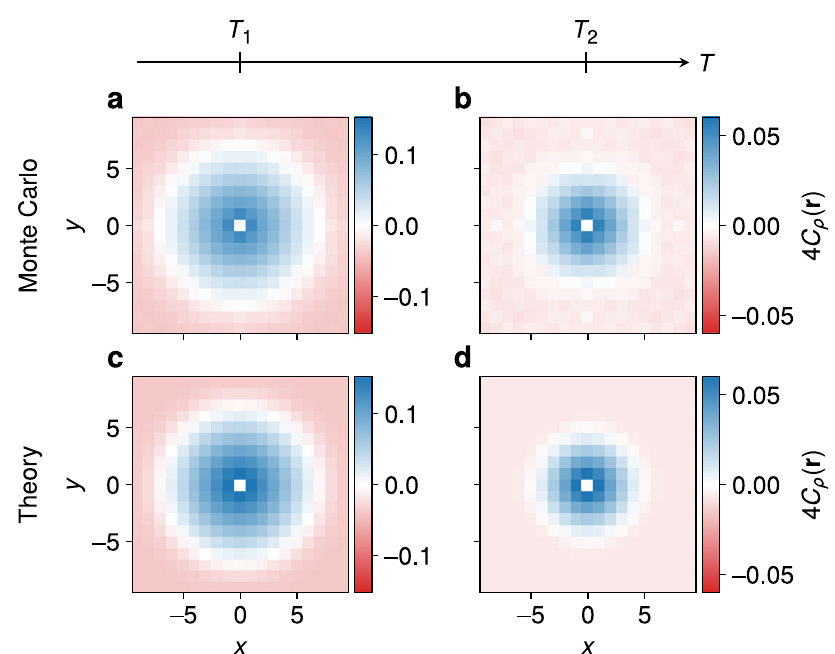
Fig. 3 Equilibrium real-space vison correlations. Connected vison correlator C ρ ( r ), r = ( x , y ), at two temperatures (marked for reference also in Fig. 2), a , c T 1 / t s = 2.3 10 − 3 and b , d T 2 / t s = 9.6 10 − 3 . a , b correspond to the MC data, while c , d are the predictions of the empty disc model. As temperature is increased, the typical size of the vison-depleted patch shrinks and the length scale over which the visons are correlated is correspondingly reduced. The calculations were performed for a system of size L 2 = 20 2 satisfying periodic boundary